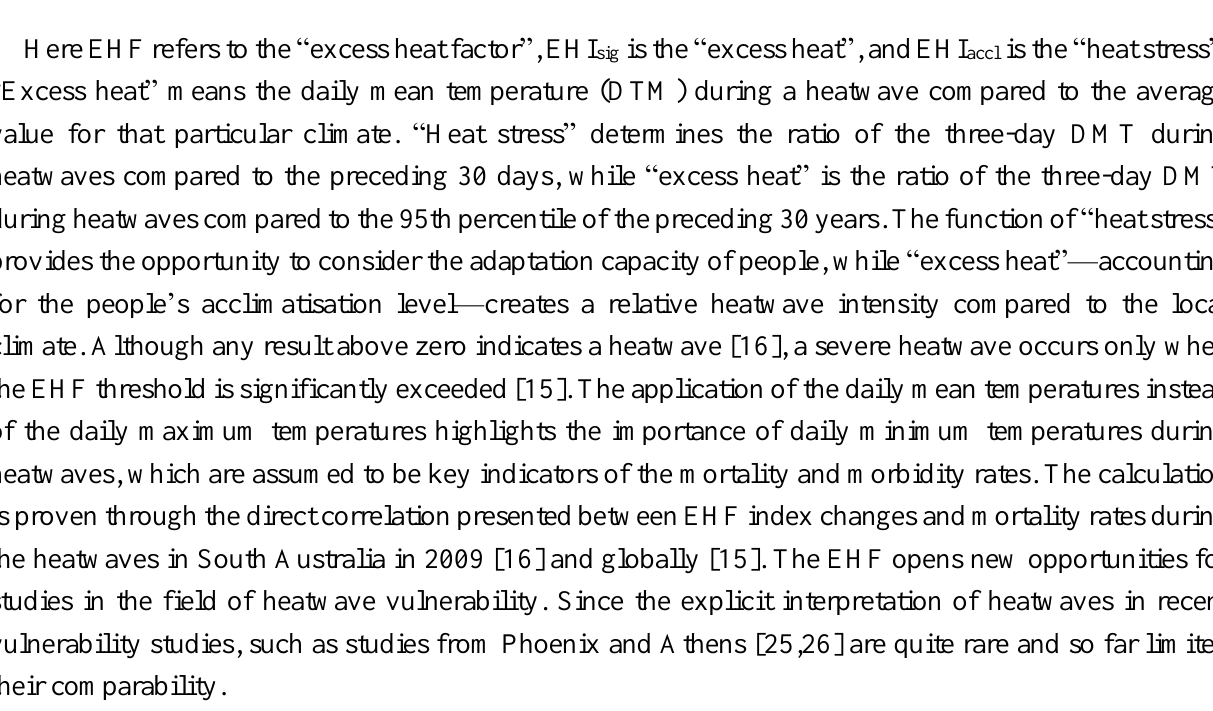
Figure 1. The indicators and impacts of urban heatwaves